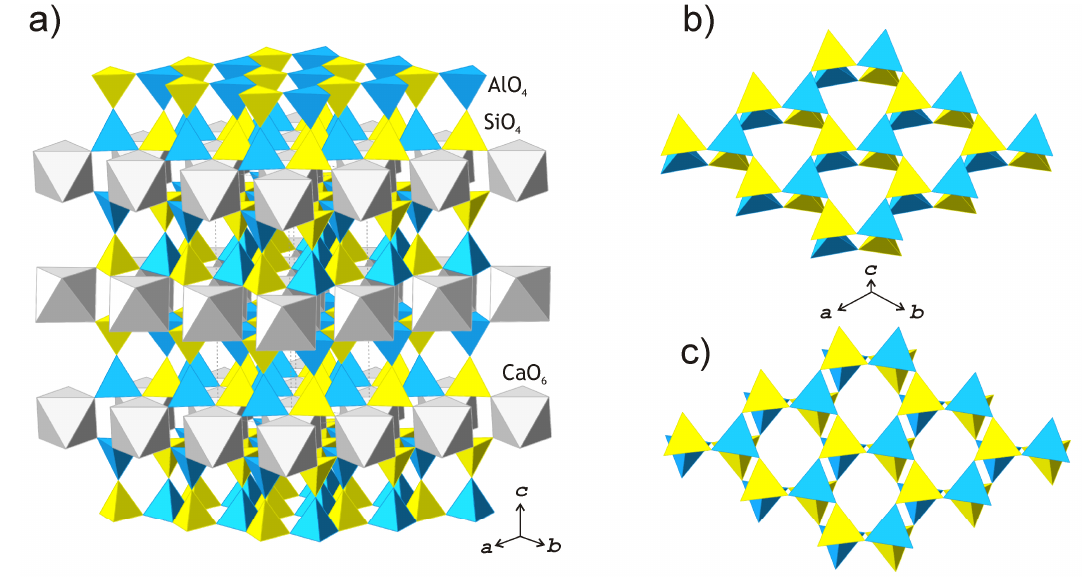
Figure 3. The crystal structure of dmisteinbergite ( a ) and views of the tetrahedral double layer when the O4 ( b ) and O4A ( c ) sites are occupied.